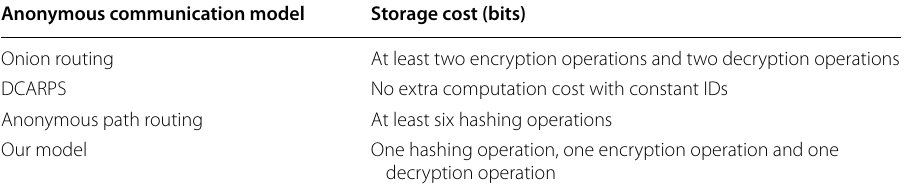
Table 3 Performance comparison on storage cost